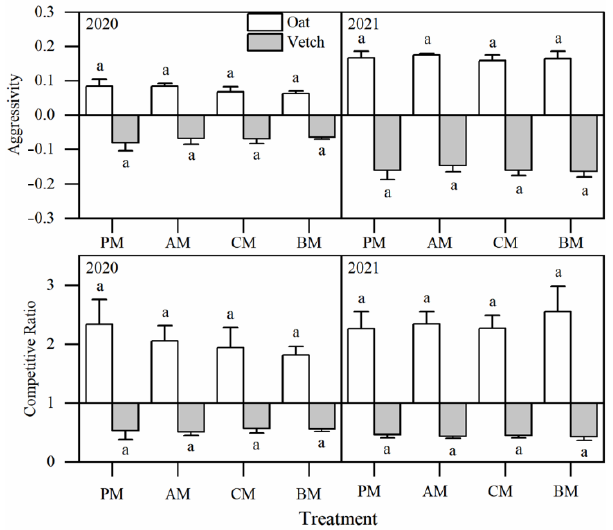
Figure 6. The aggressiveness (A) and competitive ratio (CR) among different cropping systems over two years in Yanchi county, Ningxia, China. Note: PM: peer mixing; AM: alternate-row mixing; CM: cross mixing; BM: bar mixing. Different lowercase letters indicate a significant difference at p < 0.05.